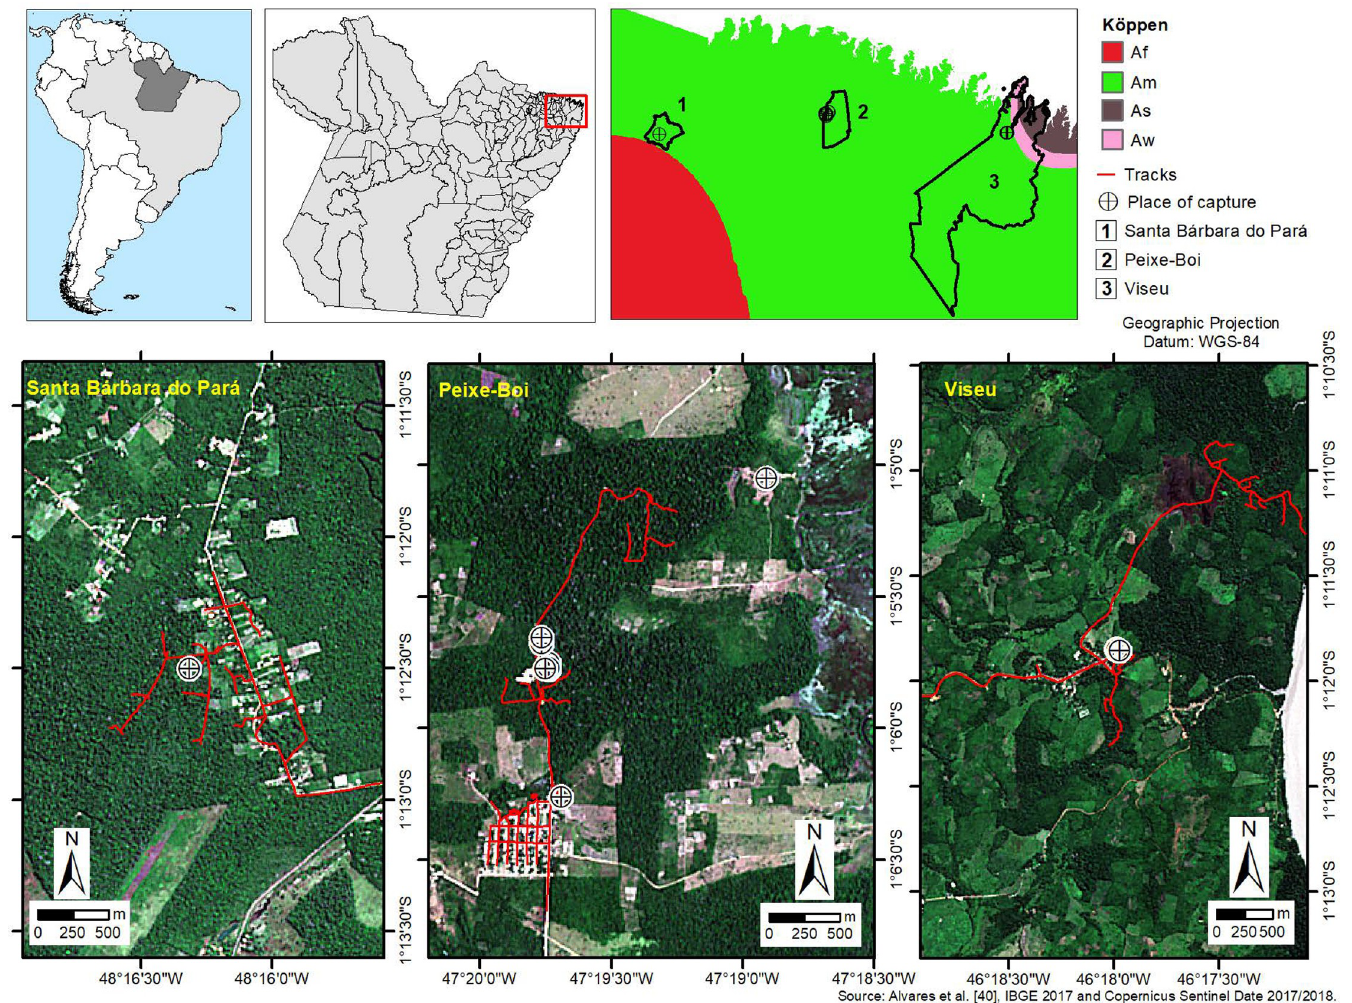
Fig 1. Place of study and capture of the